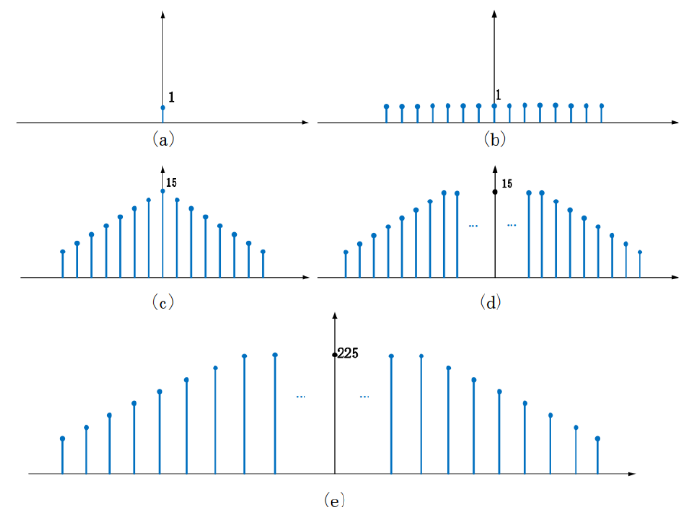
Figure 3. Principle of calculating the reflection coefficient schematic diagram. ( a ). Periodic pulse signal is applied to T 2 . ( b ). The excitation pulse signal is convoluted with a 15 cycle pulse sequence. ( c ). The electrical signal converted from SAW propagates to T 3 . ( d ). The convolution of the incident SAW and the transfer function of the reflectors. ( e ). Reflection signal V g from T 3 .